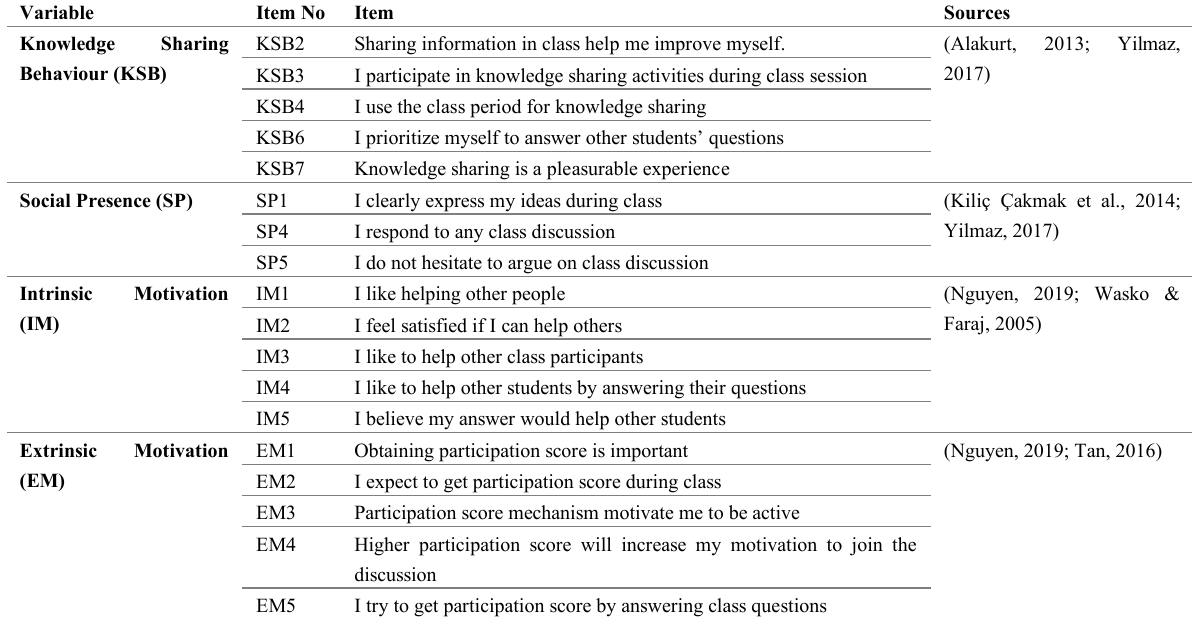
Table 1: Structure of